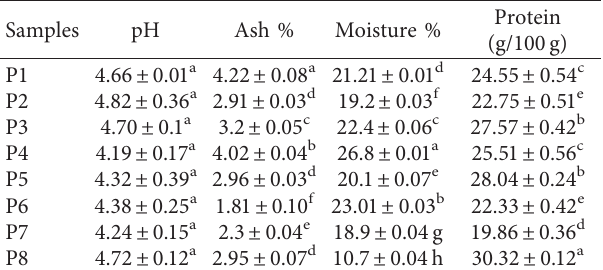
Values in the same column followed by the same letter are not significantly